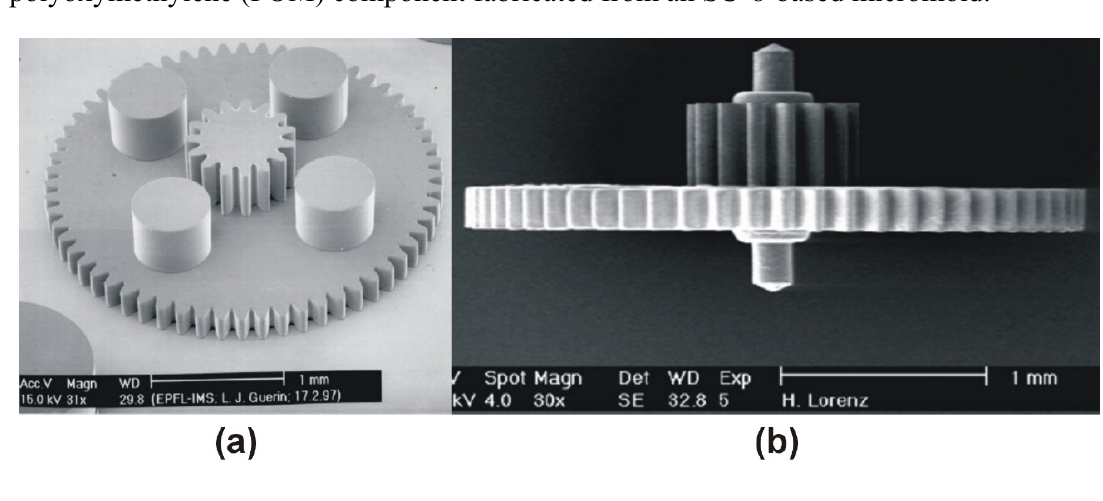
Figure 3. ( a ) Two-level photoplastic SU-8 structure as a basis for micromold fabrication. From [6], © 1997 IEEE; ( b ) A micromolded multi-auto-oriented-level plastic polyoxymethylene (POM) component fabricated from an SU-8-based